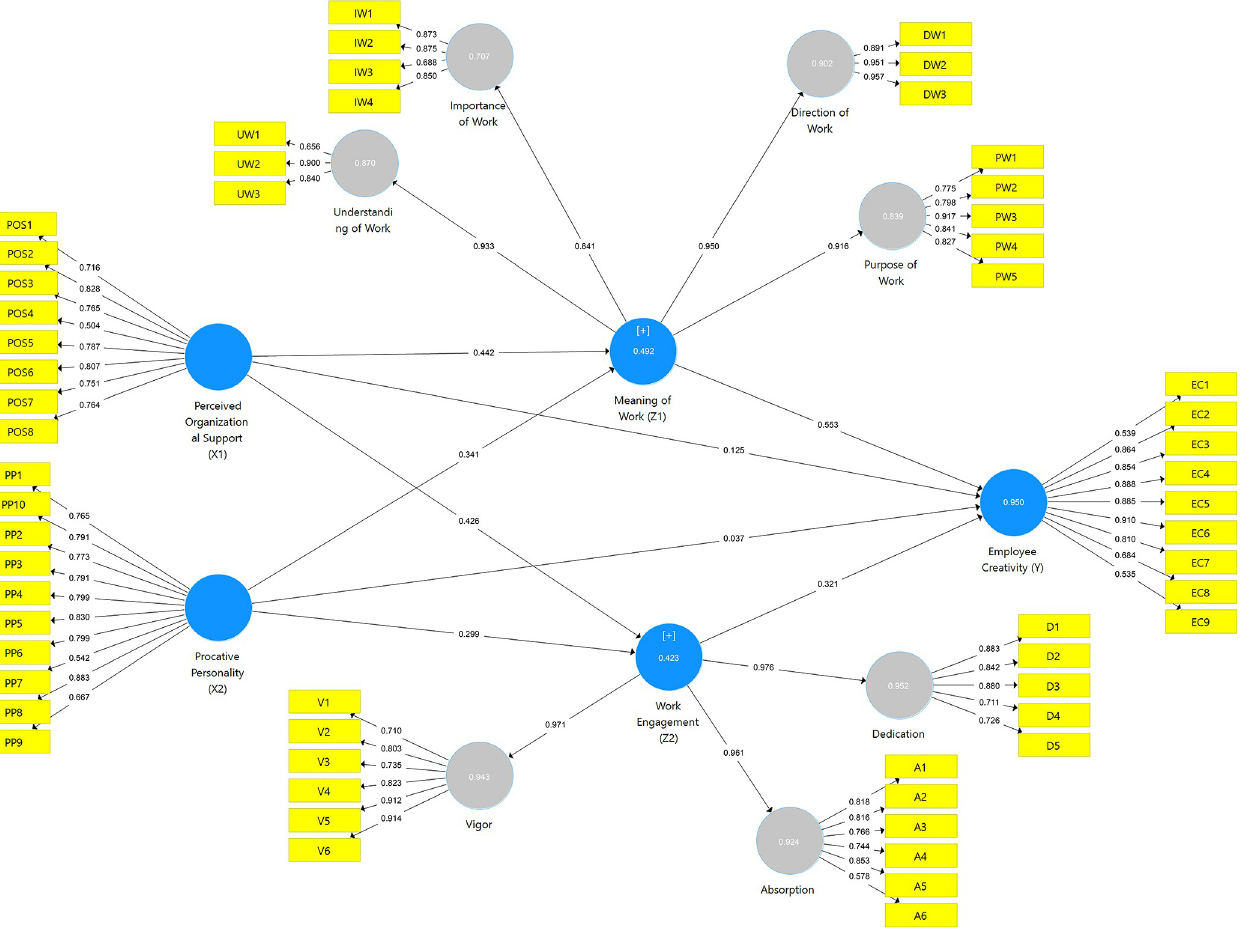
Fig 2. PLS algorithm. Estimation